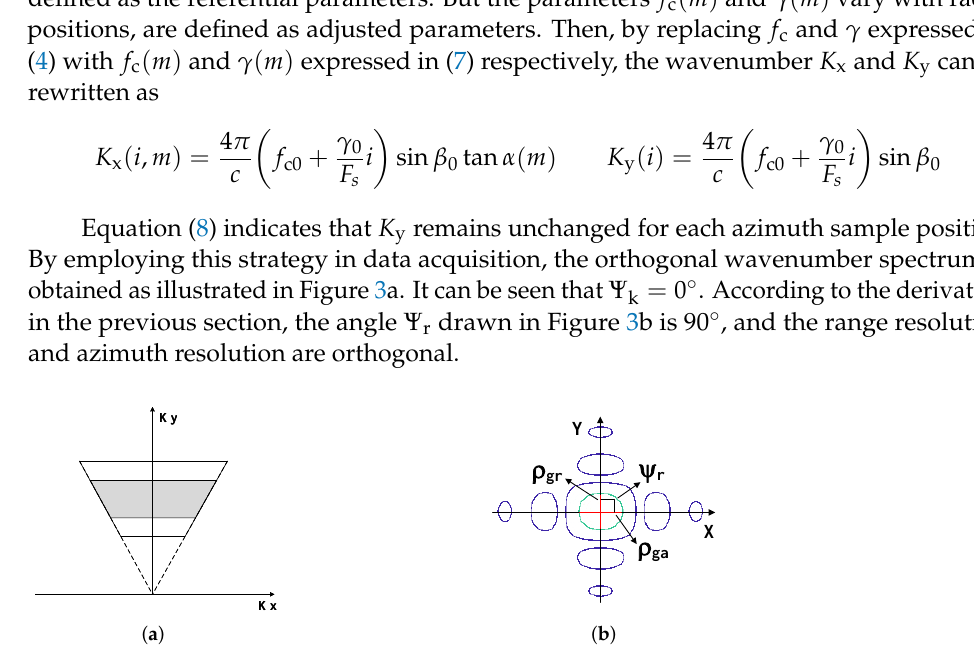
Figure 3. Illustrations of wavenumber spectrum and PSF in the EHS parameter-adjusting SAR with ( a ) wavenumber spectrum and ( b ) PSF on XOY plane.